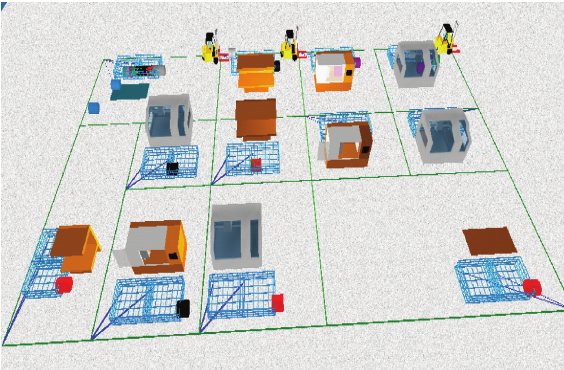
Figure 3: Three-dimensional